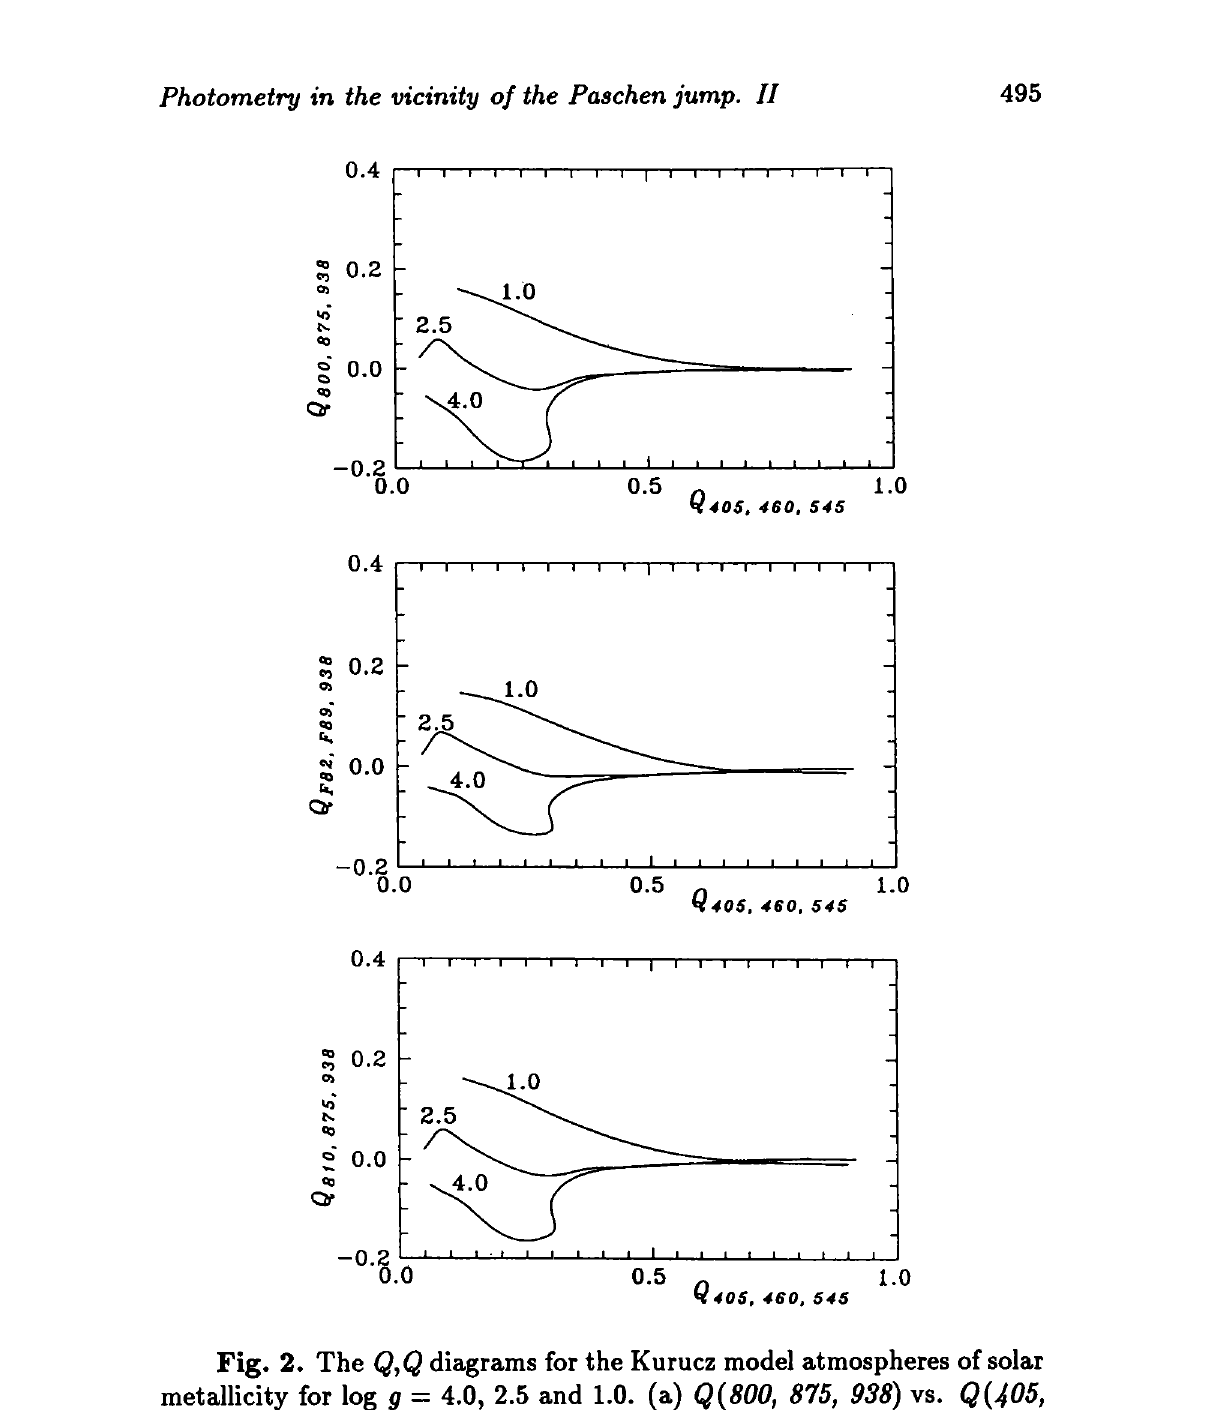
Fig. 2. The Q,Q diagrams for the Kurucz model atmospheres of solar metallicity for log g = 4.0, 2.5 and 1.0. (a) Q(800, 875, 938) vs. Q(405, 460, 545 ); (b) Q(F82, F89, 938) vs. Q(405, 46O, 545)\ (c) Q(810, 875, 938) vs. Q(405, 460,